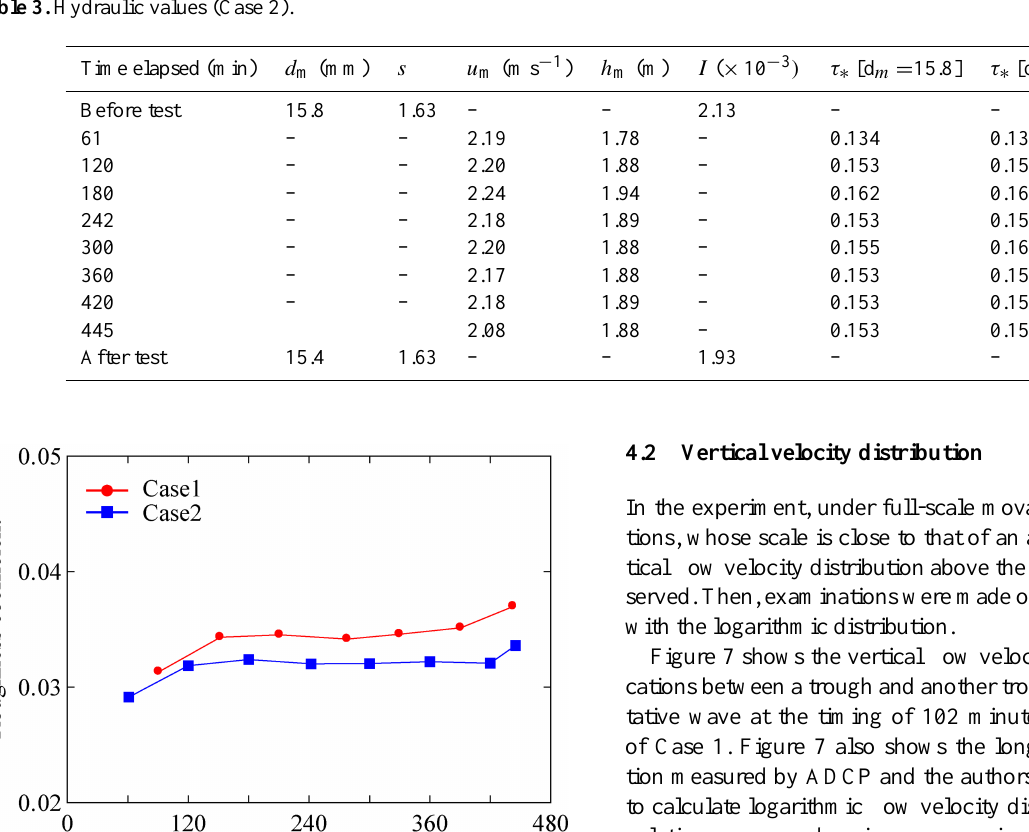
Table 3. Hydraulic values (Case 2).